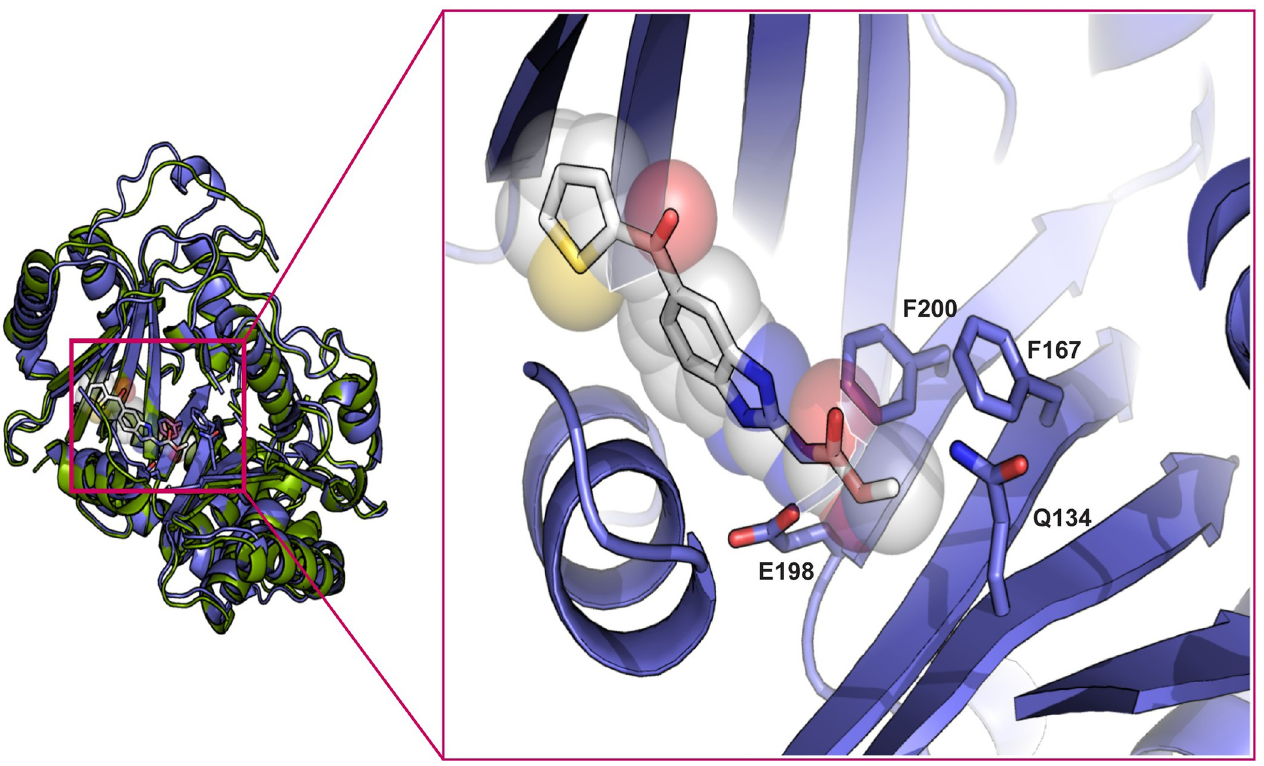
Fig 2. In-silico protein structural model of the A . caninum isotype-1 β -tubulin bound to nocodazole. Structural model for A . caninum isotype-1 β -tubulin made using AlphaFold2 (PMID: 34265844) (purple) aligned to Porcine β -tubulin (green) bound to nocodazole (white) (from PDB 5CA1). The inset shows a zoom into the binding site, with positions of residues at codons 134, 167, 198, and 200 indicated. These resistance mutation positions are all in direct van der Waals contact with the constant portion of benzimidazole